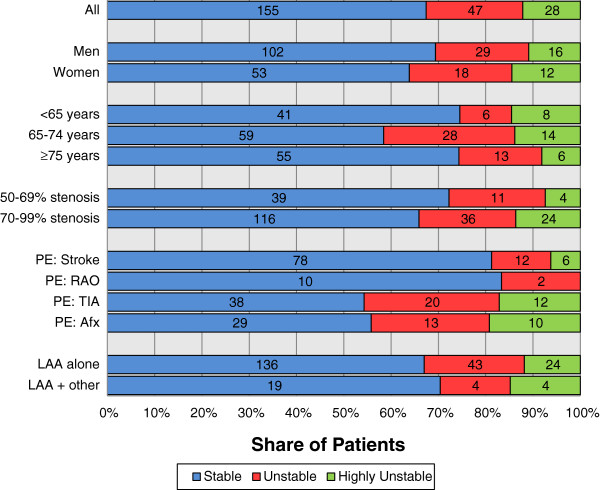
Prevalence of additional ipsilateral events. Numbers inside bars denotes number of patients. PE = presenting event; RAO = retinal artery occlusion; Afx = amaurosis fugax; LAA = large artery atherosclerosis